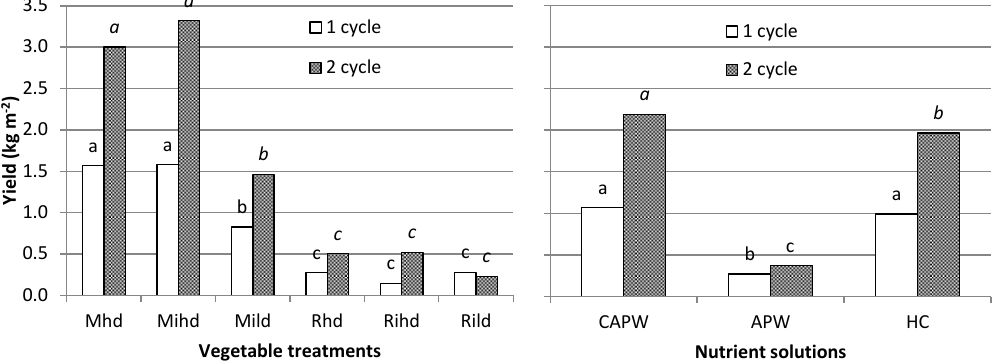
Figure 8. Effect of vegetable treatments and nutrient solutions on yields from two growth cycles. M HD : mizuna high density; M IHD : mizuna intercropped high density; M ILD : Mizuna intercropped low density; R HD : rocket salad high density; R IHD : rocket salad intercropped high density; R ILD : rocket salad low density; HC: hydroponic control; APW: aquaponic water; CAPW: complemented aquaponic water. Different letters on the same DAS indicate significant differences, with p < 0.05, based on Tukey HSD Test.